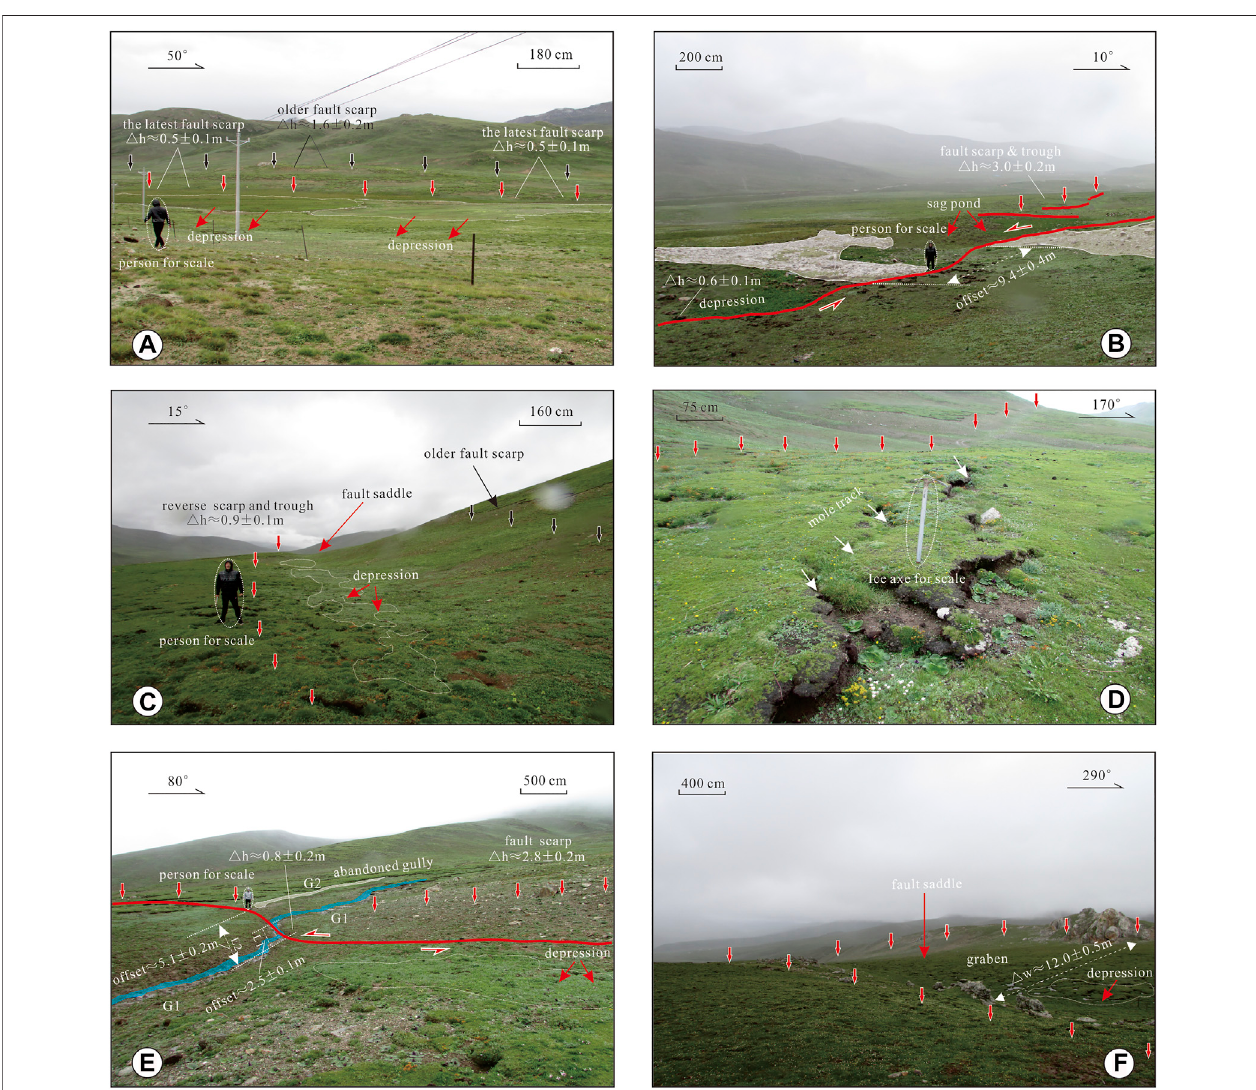
FIGURE 4 | Diagrammatic features of the CE 1738 co-seismic surface ruptures along the western section of the DJF. Red arrows represent the distribution of the latestco-seismiccharacteristics,whiletheblackarrows delineatethedistributionoftheolderfaultscarp.Theazimuthanglesinthemaps representthesectiondirection. Note thescaledifferenceineachpicture. Picturesfrom,tocorrespondtotheinvestigated sitesin Figure3 W. (A) Faultscarp,trough,anddepressionsdeveloped within unconsolidated alluvial and pluvial sediments, which are duplicated in a preexisting structure zone. Note the youngest gully terrace was vertically dislocated by approximately 0.5± 0.1 m, while theheightoftheolderfault scarp isof~1.6 ±0.2 m; (B) Agullywasoffset (by9.4±0.4 m) byapreexistingfaultand co-seismicsurface ruptures where a fault scarp was observed with a height of ~3.0 ± 0.2 m at a site located ~1 km northwest of the gully; (C) Co-seismic surface ruptures in a preexisting faultdepressiondevelopedalongafaulttroughaccompaniedbyageomorphicscarpwithaheightof0.9±0.1 m; (D) Freshalternating enechelon fracturesandpressure ridges (marked by white arrows) are observed in the same direction with the preexisting fault (delineated by red arrows); (E) One gully was horizontally offset (by 2.5 ± 0.1 m) by the preexisting fault, while the older gully was abandoned with accumulated dislocations ~5.1 ± 0.2 m. Additionally, an ~2.8 ± 0.2 m-high geomorphic scarp and depression were observed along fault; (F) Co-seismic surface ruptures in a preexisting graben with a breadth of ~12.0 ± 0.5 m along the valley.